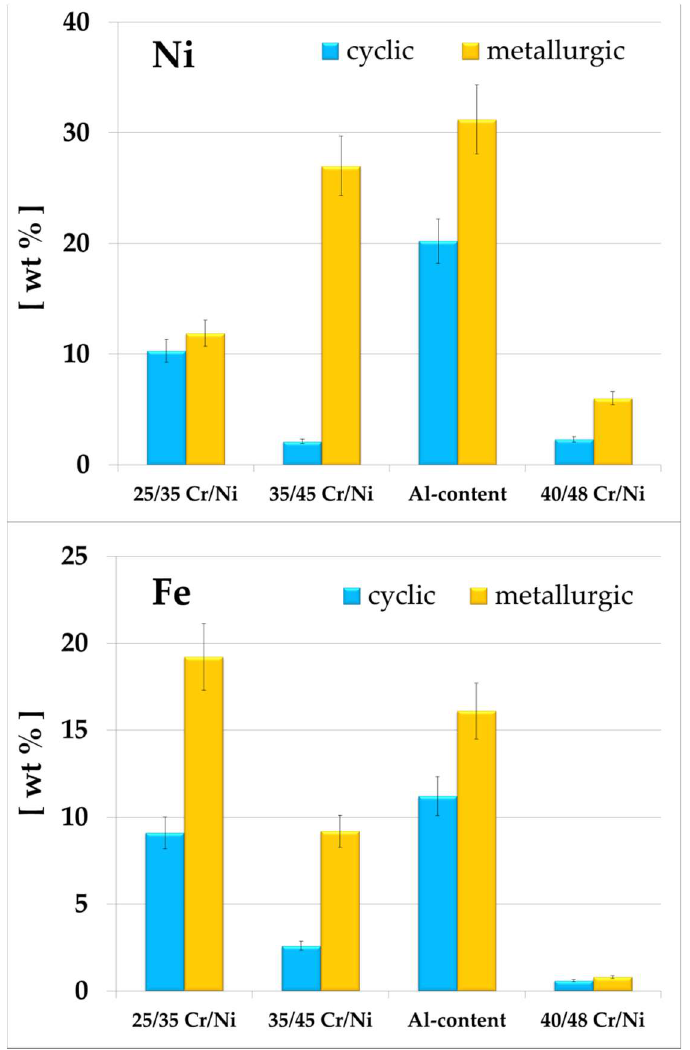
Figure 6. Ni content ( top ) and Fe content of the tested coked samples. Magnification: 50×, Accelerating voltage: 20 kV. Table 4. Top surface elemental composition for the coked samples after cyclic and metallurgic aging. Magnification: 50 × , Accelerating voltage: 10 and 20 kV. Alloy 25/35 Cr/Ni 35/45 Cr/Ni Al-Containing 40/48 Cr/Ni Elements Acc.